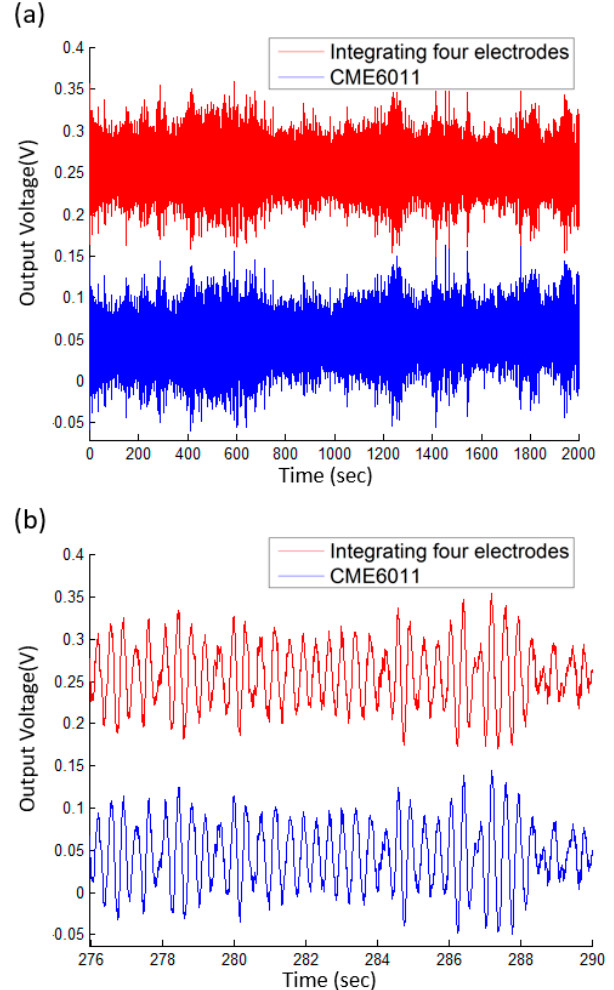
Figure 7. Test results of the electrochemical seismometer developed in this study in comparison with the commercial counterpart of CME6011 without observable ground motions, including ( a ) the normalized time-domain response and ( b ) enlarged view of the time-domain response from 276 to 290 s.